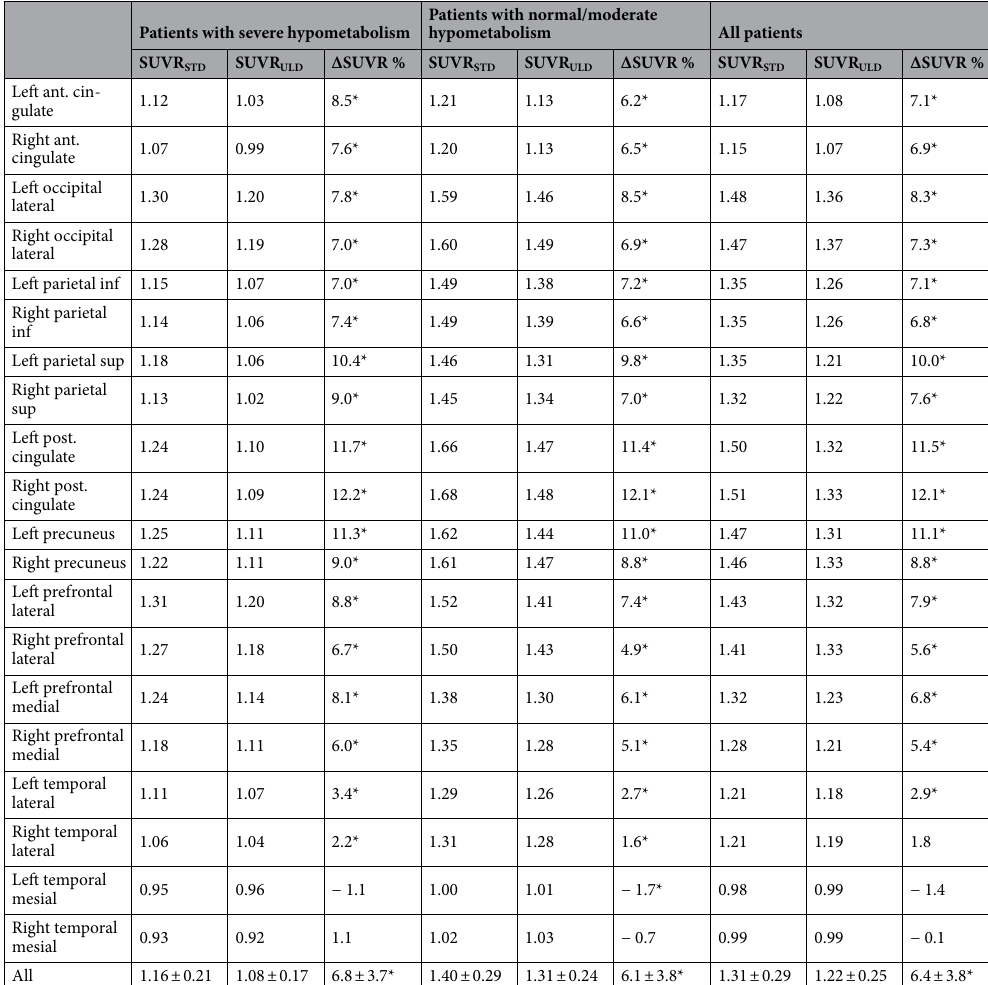
Table 3. Regional SUVR ULD, SUVR STD and difference ΔSUVR% = (SUVR STD – SUVR ULD )/SUVR STD expressed as mean ± standard deviation. *Indicates statistically significant difference between SUVR STD and SUVR ULD with p < 0.05. Ant. anterior, Post. posterior, Sup. superior, Inf.